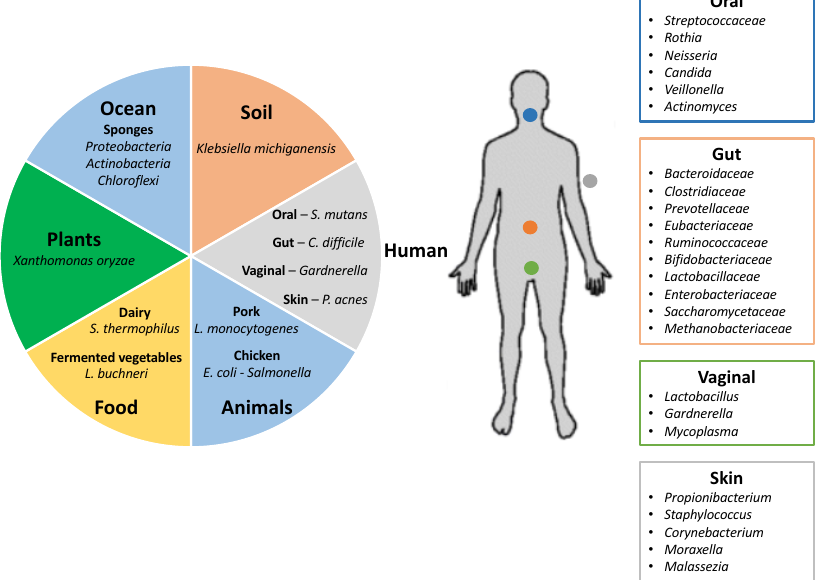
Figure 1. Human microbiome and virome. Different environments showing commensal and pathogenic bacteria that carry Clustered Regularly Interspaced Short Palindromic Repeats (CRISPR)-Cas immune systems as defense mechanisms against invasive nucleic acids from phages and plasmids ( left panel ). Distribution of the human microbiome in the most representative body sites, including some of the species that contain CRISPR-Cas immune systems ( right panel ) (adapted from Lloyd-Price and co-workers